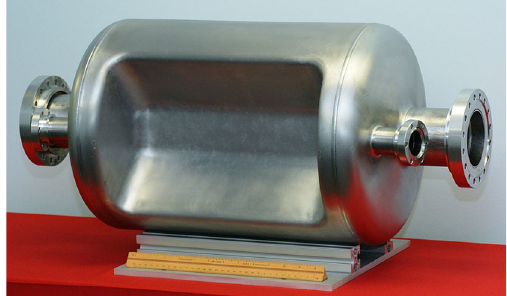
FIG. 4. Fabricated 400 MHz rf-dipole